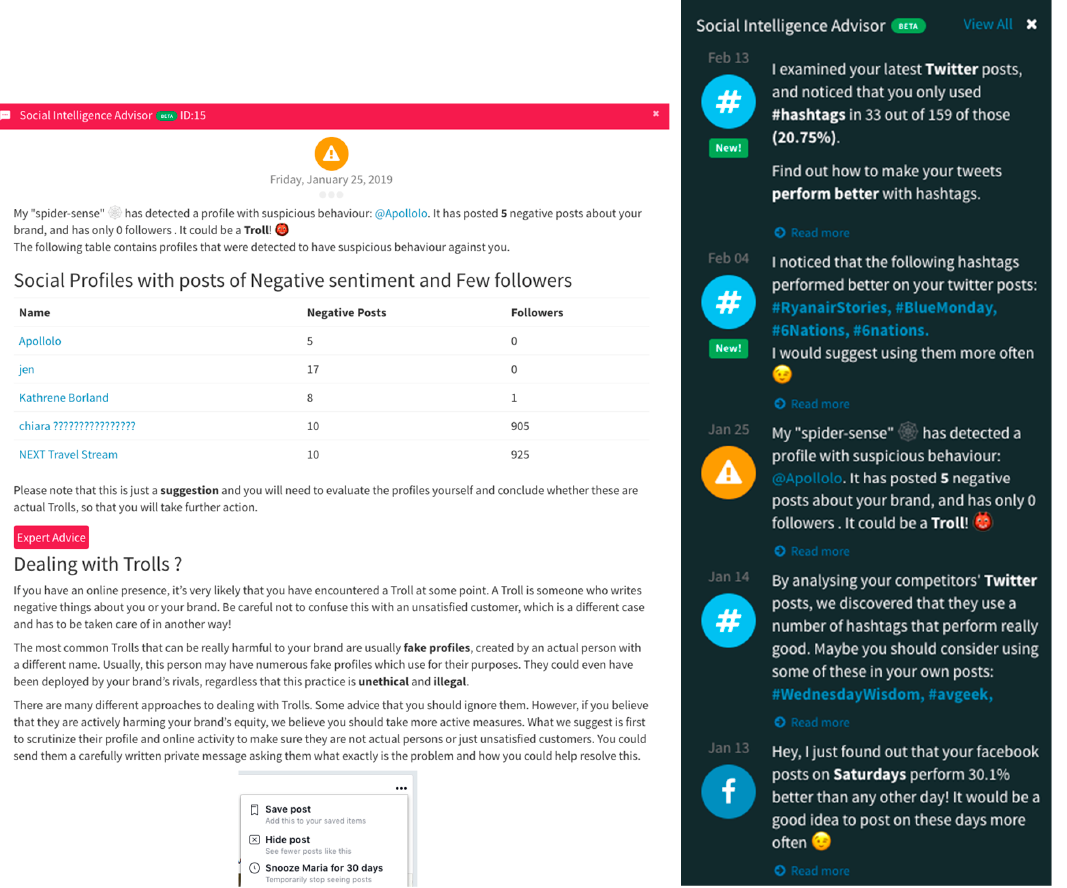
Figure 4. Social intelligence advisor suggestions.